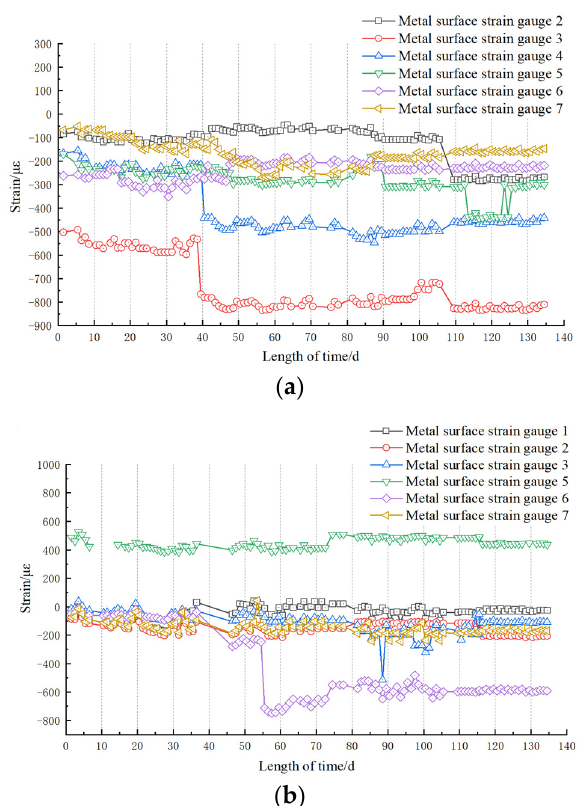
Figure 21. Strain curve of steel waist beam. ( a ) side slopes on the toppling rock side; ( b ) side slopes on the bedding rock side.